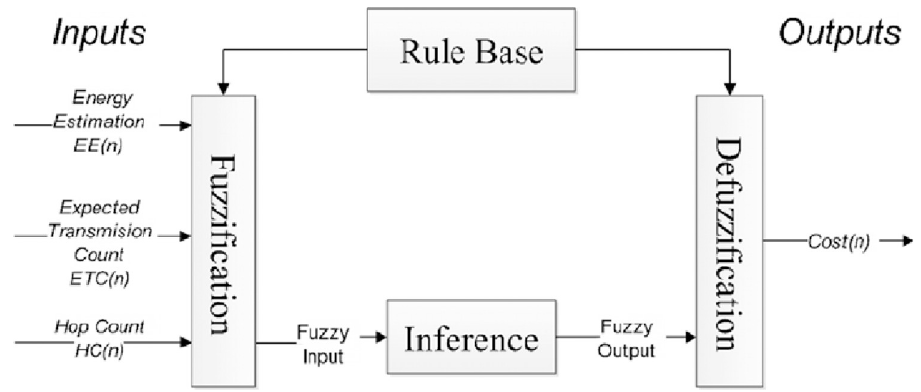
Fig 3. Schematic of the proposed fuzzy system.